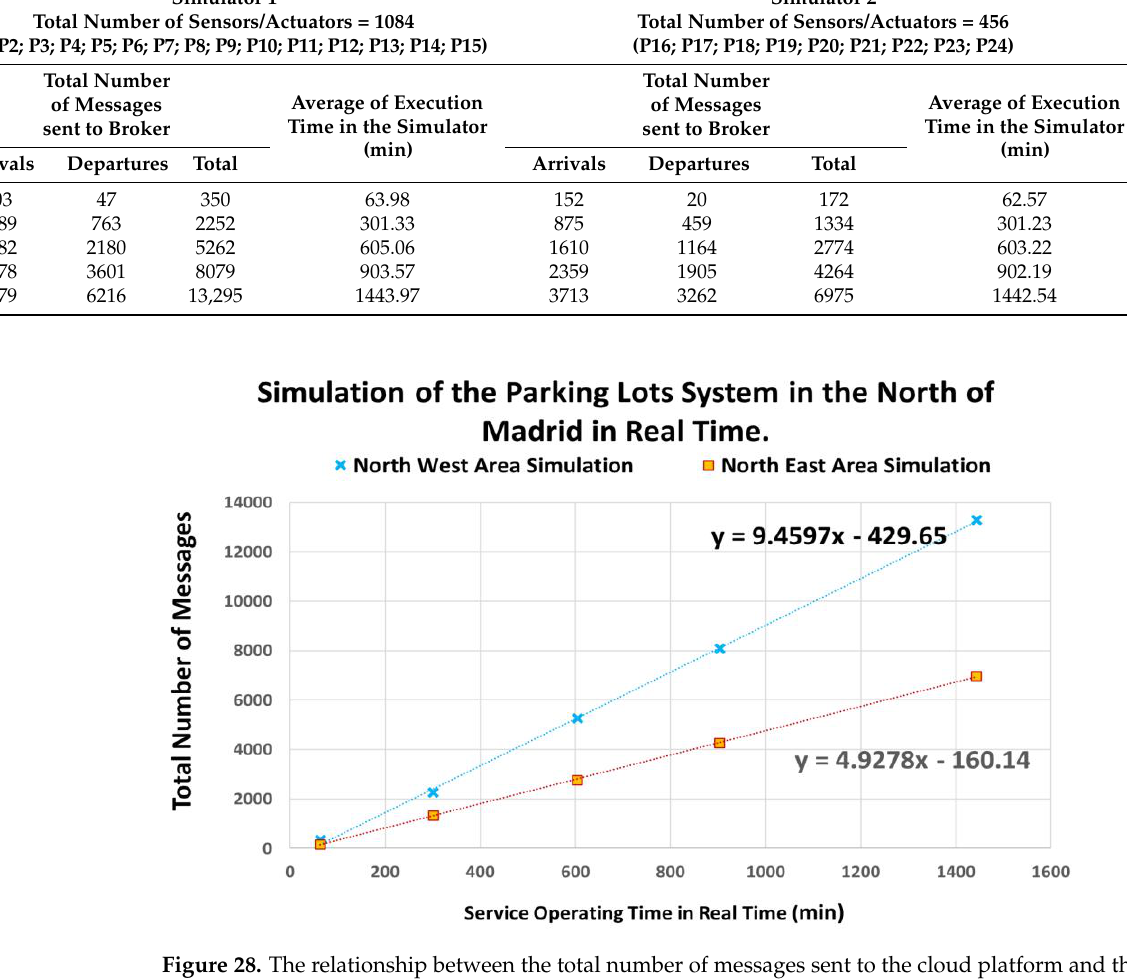
Figure 28. The relationship between the total number of messages sent to the cloud platform and real time is the real time is linear.